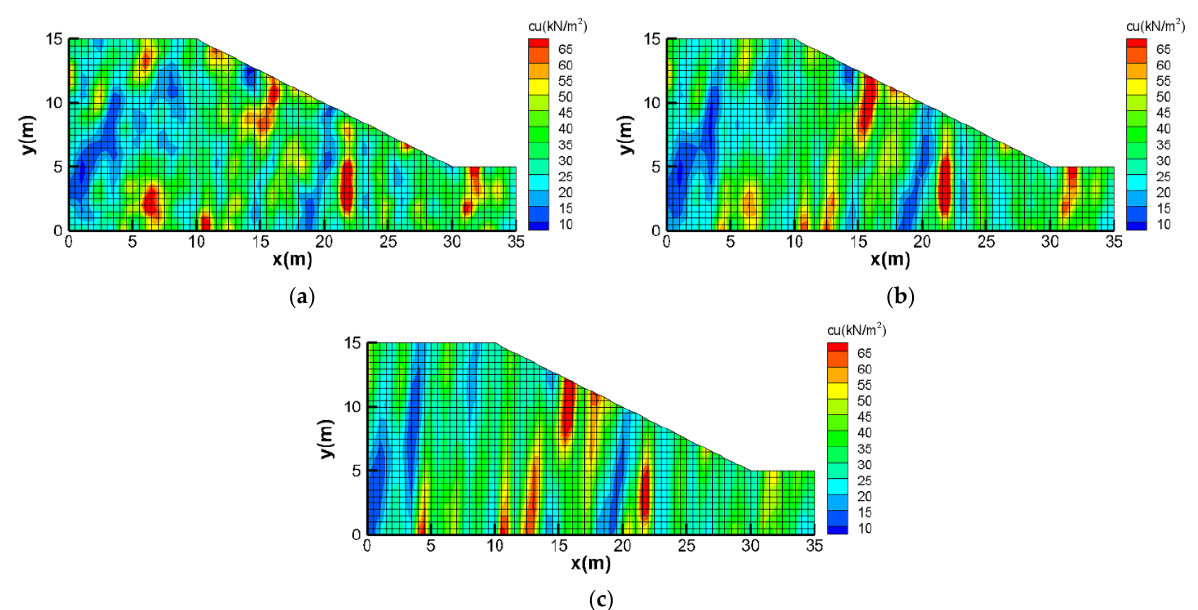
Figure 3. Numerically generated statistically anisotropic undrained shear strength fields ( λ x < λ y ): ( a ) λ x = 0.5 m, λ y = 2 m, ( b ) λ x = 0.5 m, λ y = 5 m and ( c ) λ x = 0.5 m and λ y = 25 m.